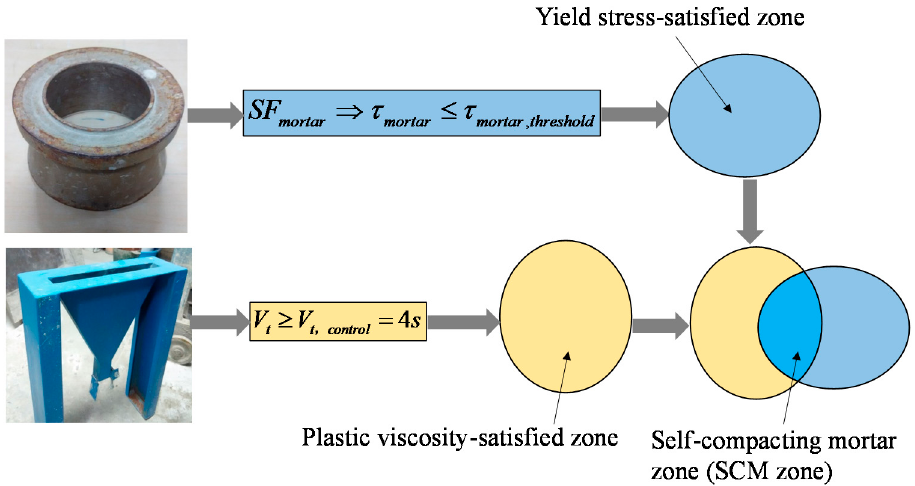
Figure 3. Criteria for obtaining the self-compacting concrete zone.